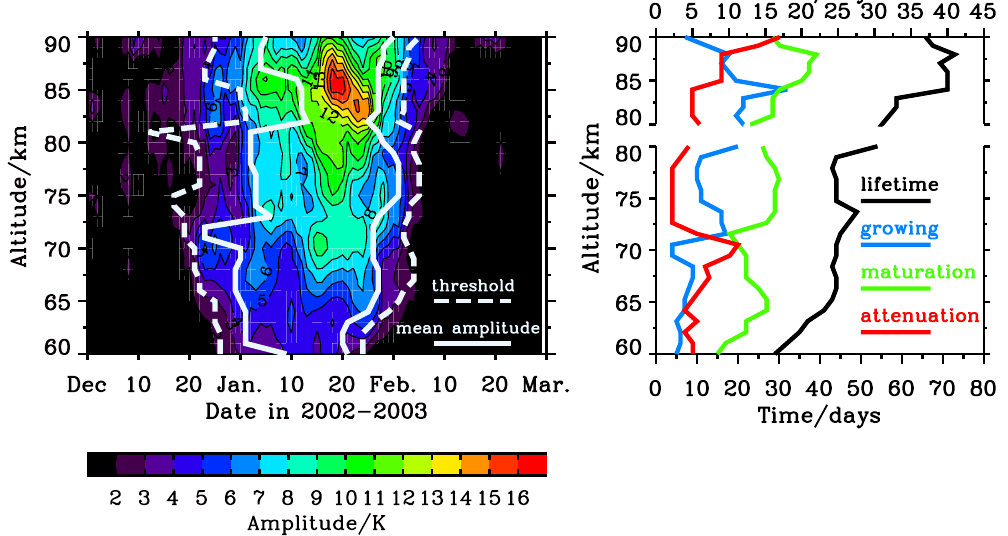
Fig. 3. Time–altitude variations of amplitudes of (2.13, W3) (left). Solid and dashed lines are profiles of mean amplitude and threshold, indicating time limit of maturation stage and lifetime. Altitude variations of durations of lifetime (black line), growing stage (blue line), maturation stage (green line) and attenuation stage (red line) are shown in the right panel. The bottom and upper x-axes in the right panel are for altitude ranges below and above 80km,